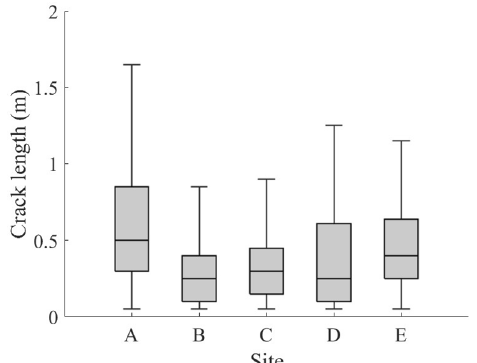
Fig. 5 Longitudinal length of cracks in logs harvested at each site. (The line inside each box is the sample median. The whisker connects the upper quartile to the non-outlier maximum.)